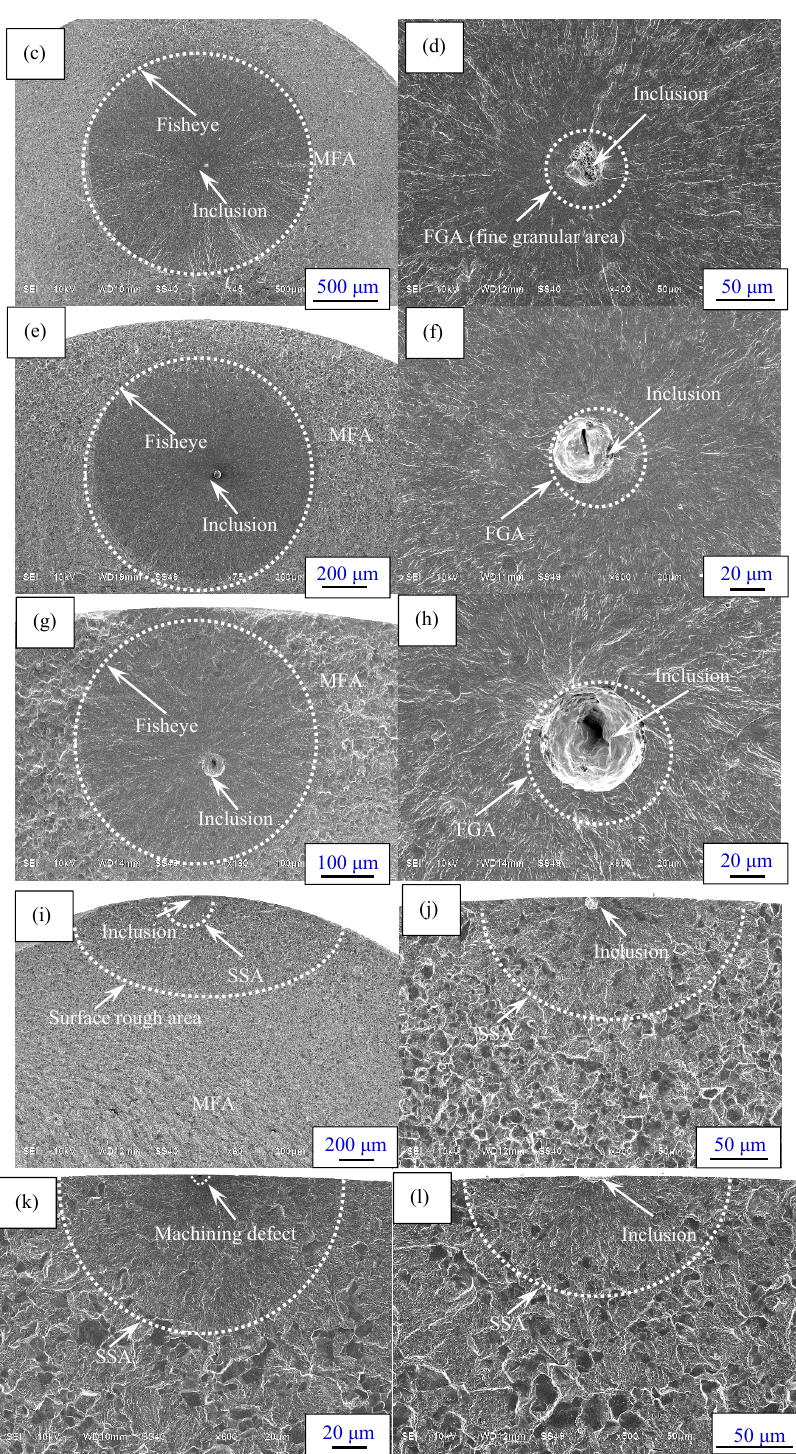
Figure 6. Observation of fracture surfaces: ( a ) Fisheye ( σ a = 800 MPa, N f = 370,800 cycles, R = − 1); ( b ) Inclusion without fine granular area (FGA) ( σ a = 575 MPa, N f = 4,254,700 cycles, R = 0); ( c ) Fisheye ( σ a = 700 MPa, N f = 4,768,700 cycles, R = − 1); ( d ) Inclusion with FGA ( σ a = 700 MPa, N f = 4,768,700 cycles, R = − 1); ( e ) Fisheye ( σ a = 575 MPa, N f = 4,254,700 cycles, R = 0); ( f ) Inclusion with FGA ( σ a = 575 MPa, N f = 4,254,700 cycles, R = 0); ( g ) Fisheye ( σ a = 455 MPa, N f = 9,494,900 cycles, R = 0.3); ( h ) Inclusion with FGA ( σ a = 455 MPa, N f = 9,494,900 cycles, R = 0.3); ( i ) Surface failure ( σ a = 650 MPa, N f = 82,100 cycles, R = 0); ( j ) Inclusion ( σ a = 650 MPa, N f = 82,100 cycles, R = 0); ( k ) Surface machining defect ( σ a = 600 MPa, N f = 1,945,900 cycles, R = 0); ( l ) Inclusion ( σ a = 490 MPa, N f = 100,200 cycles, R =